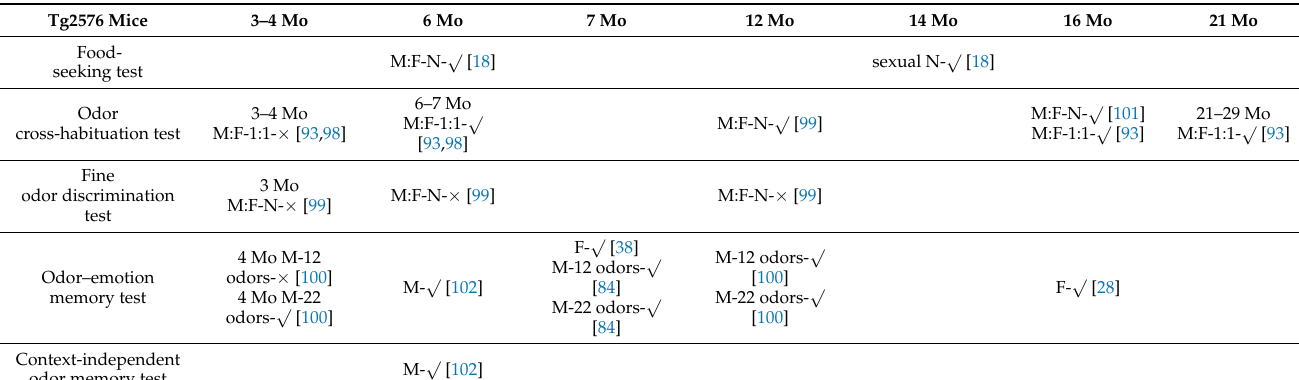
Table 3. Summary of data on the behavioral performance of the Tg2576 mice; “3–4 Mo M:F-1:1-X” represents “age-sex-sex ratio-whether there is a difference”. Mo: month, M: male, F: female, N: √ unclear, × : no significant difference, : significant difference.